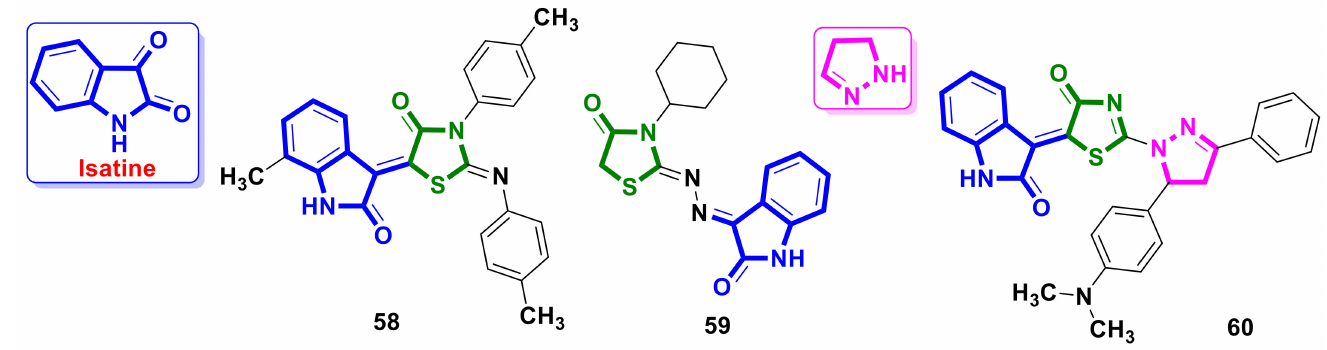
Figure 23. Isatine-based 4-thiazolidinone hybrid molecules with anticancer activity.